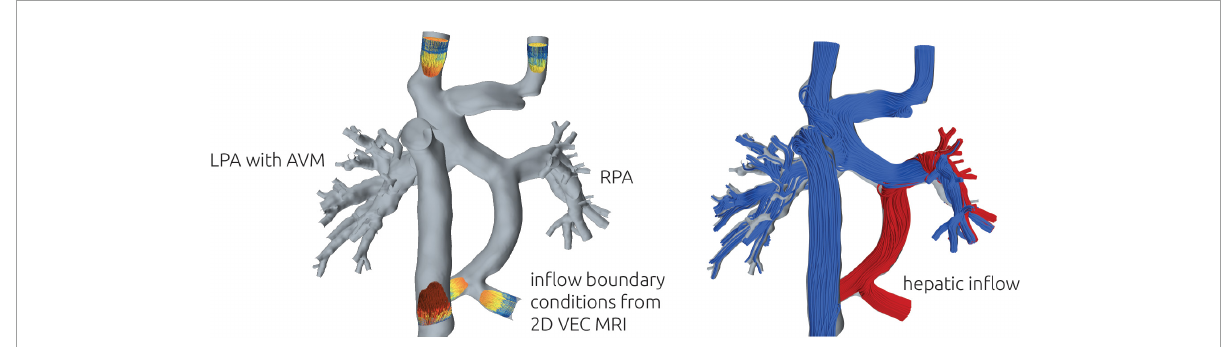
FIGURE3 Illustration of the numerical setup (left). At all vessels except LPA and RPA, the patient-specific volume flow rate measured using 2D VEC CMR was specified as boundary conditions. 2D VEC CMR measurements at the LPA and RPA were used to specify the relative ratio of blood leaving the domain through each respective vessel. To illustrate the distribution of hepatic blood flow, streamlines of different color were seeded from the respective vessels (right). The example illustrates a total separation, with no hepatic blood (red) reaching the LPA.